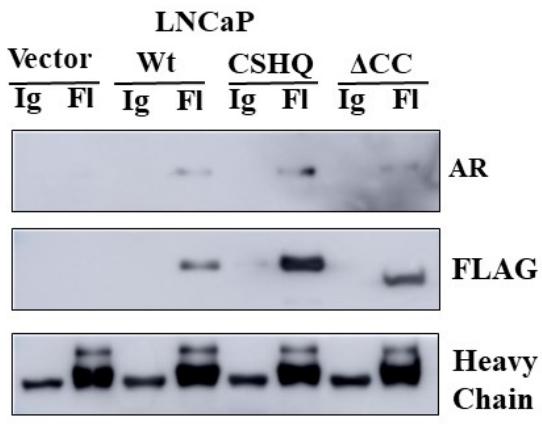
Figure 5. The interaction between NRDP1 and the androgen receptor does not require the NRDP1 coiled coil domain. Transfection with the Wt, CSHQ, or Δ CC FLAG-tagged NRDP1 constructs (3 µg per 100 mm dish, 72 h) followed by FLAG immunoprecipitation and western blot demonstrated that NRDP1 can bind to the androgen receptor (AR) in LNCaP cells. The ability of the Δ CC construct, which is missing the NRDP1 coiled coil domain, to mediate AR pulldown indicates that the coiled coil domain is not required for interaction between AR and NRDP1. Detailed information about Western Blot can be found at supplementary materials.